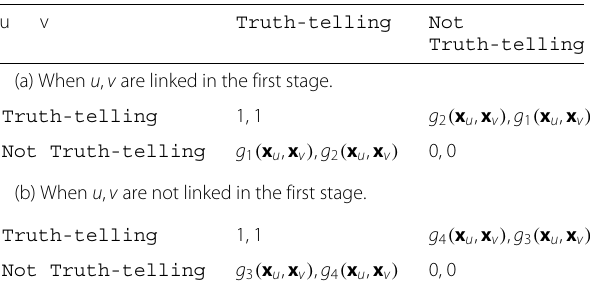
Table 2 Utility table of the second stage in the game for noisy